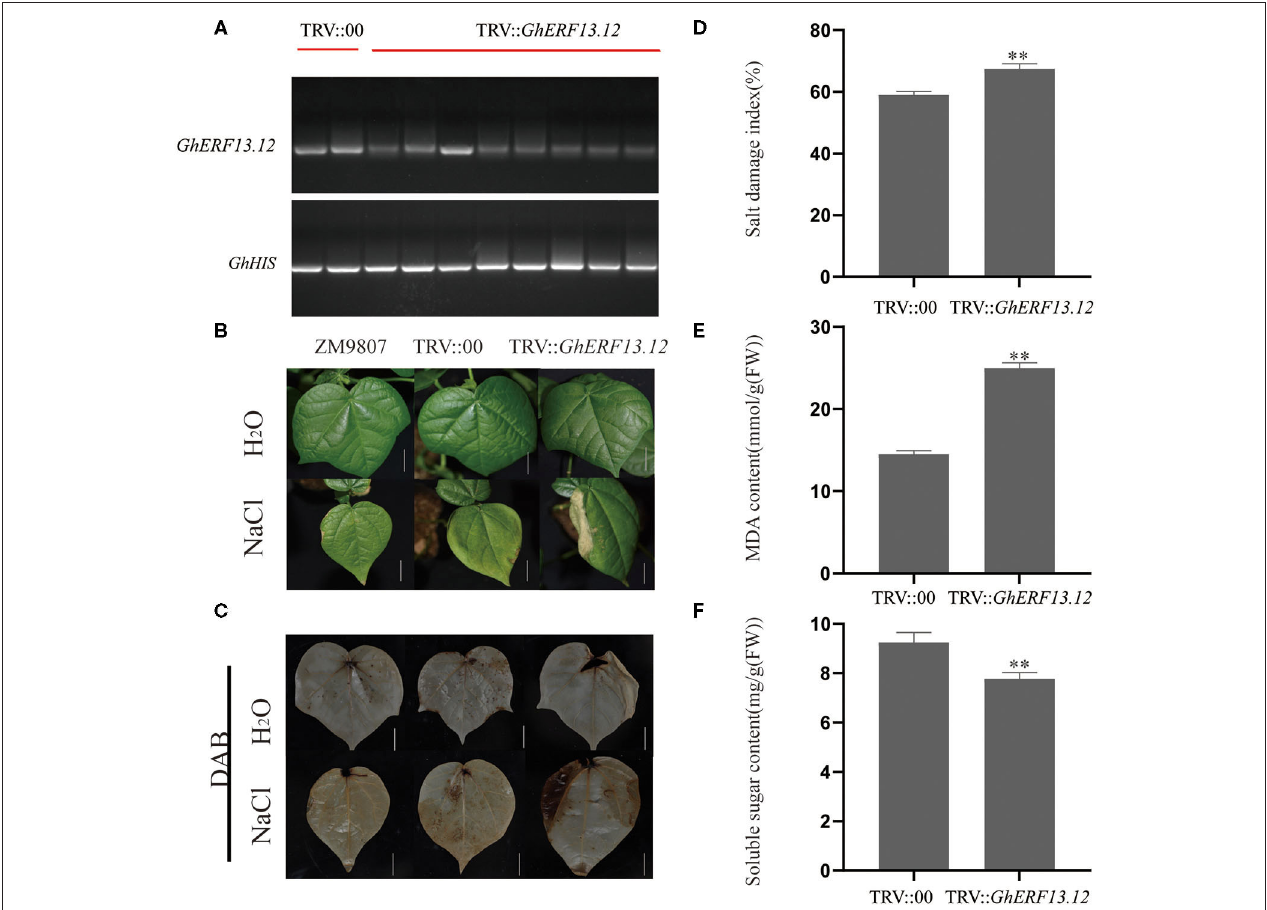
FIGURE 7 | Gene silencing of GhERF13.12 and salt stress treatment in cotton. GhERF13.12 was silenced by virus-induced gene silencing (VIGS). (A) RT-PCR expression analysis of TRV::00 and TRV:: GhERF13.12 plants to validate the silencing of the GhERF13.12 gene. GhHIS3 was used as an internal control. (B) Salt stress treatment of ZM9807, TRV::00, and TRV:: GhERF13.12 plants with and without salt stress. Bar = 2.5cm. (C) DAB staining of ZM9807, TRV::00, and TRV:: GhERF13.12 plants with and without salt stress. Other parameters, such as (D) salt damage index, (E) MDA content, and (F) soluble sugar content were observed in TRV::00 and TRV:: GhERF13.12 plants. The standard deviation among three biological replicates is shown by the error bars. ** p < 0.01 (Student’s t